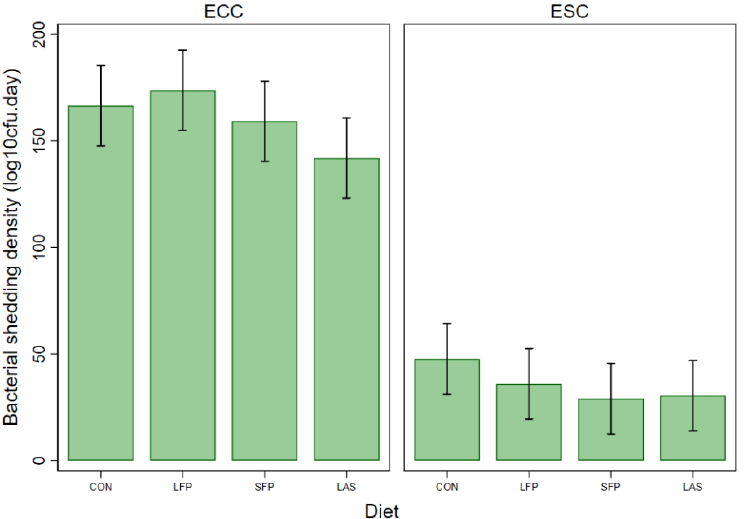
Figure 3. The total E. coli (ECC) and ESC-resistant E. coli (ESC) shedding density, a measure of bacterial shedding across the full duration of the trial, in pigs ( n = 16 per timepoint) belonging to different dietary treatment groups. Error bars are standard error of the means. Treatment abbreviations: CON = control diet, LFP = CON + 2000 ppm Lactobacillus acidophilus fermentation product (LFP), SFP = CON + 2000 ppm Saccharomyces cerevisiae fermentation product (SFP), LAS = CON + 2000 ppm LFP + 2000 ppm SFP.